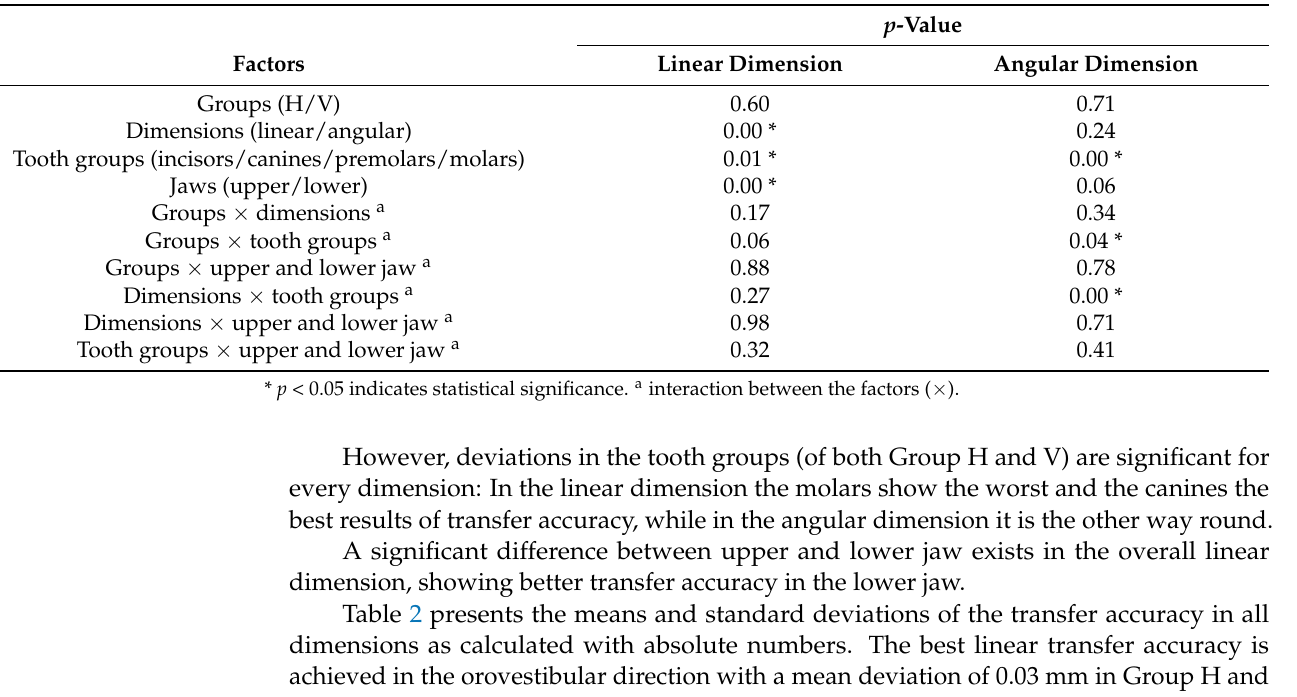
Table 1. Mixed model: Fixed effects for the linear and angular dimension.